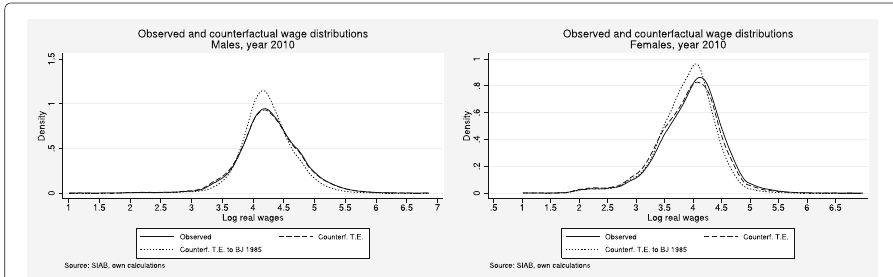
Fig. 15 Comparison of observed, counterfactual total employment and reweighted counterfactual total employment sample (specification